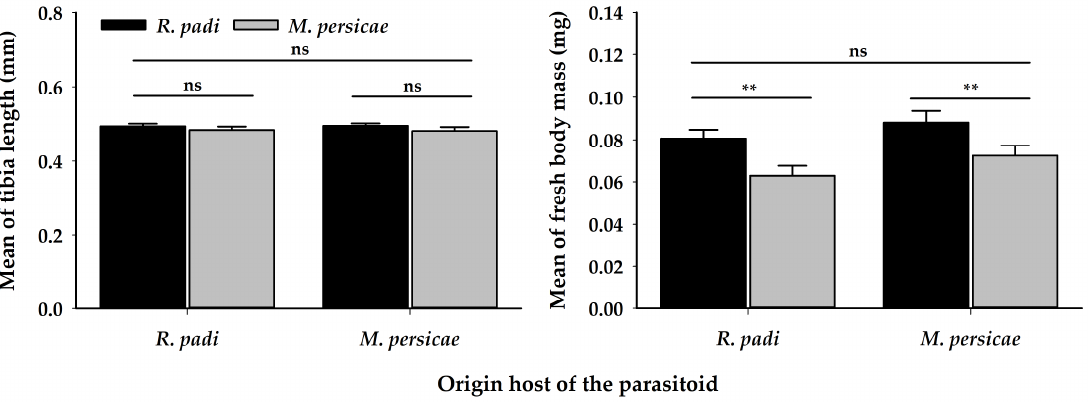
Figure 7. Total developmental time (mean ± SE) of A. platensis emerged from R. padi and M. persicae and coming from two origins ( R. padi and M. persicae ). Asterisks indicate significant differences: ‘***’ p < 0.001, ‘**’ p < 0.01 ‘*’ p < 0.05, ‘ns’ non-significant p > 0.05. Black and grey bars show the chosen/tested host.